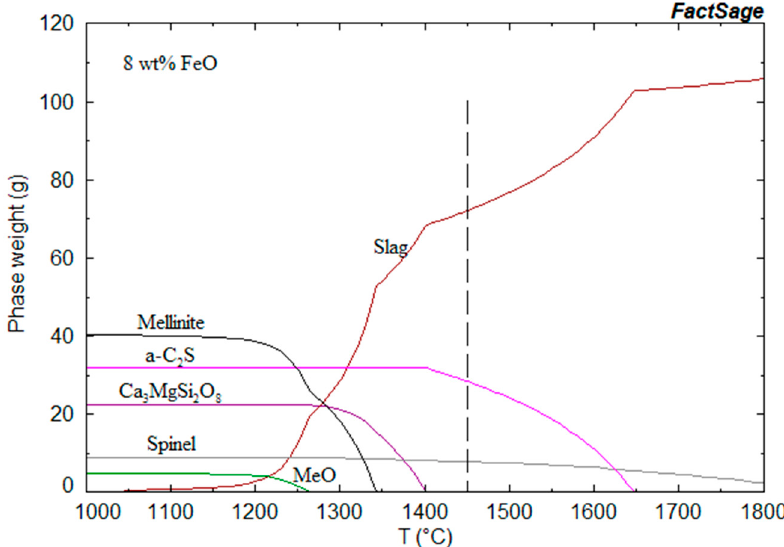
Figure 5. Theoretical analysis of the slag solidification process and selection of temperature.